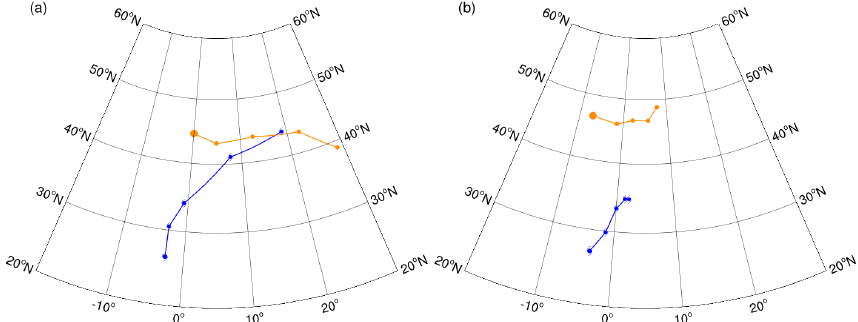
Figure 5. Track of the composite tropical cyclone (blue) and the downstream 500hPa extratropical ridge (orange) from Day − 2 to Day + 2 for (a) rapid tangential acceleration and (b) rapid tangential deceleration. The composites are based on all TC track locations within 30– 40 ◦ N. Day 0 is the reference day for the composites in Fig.